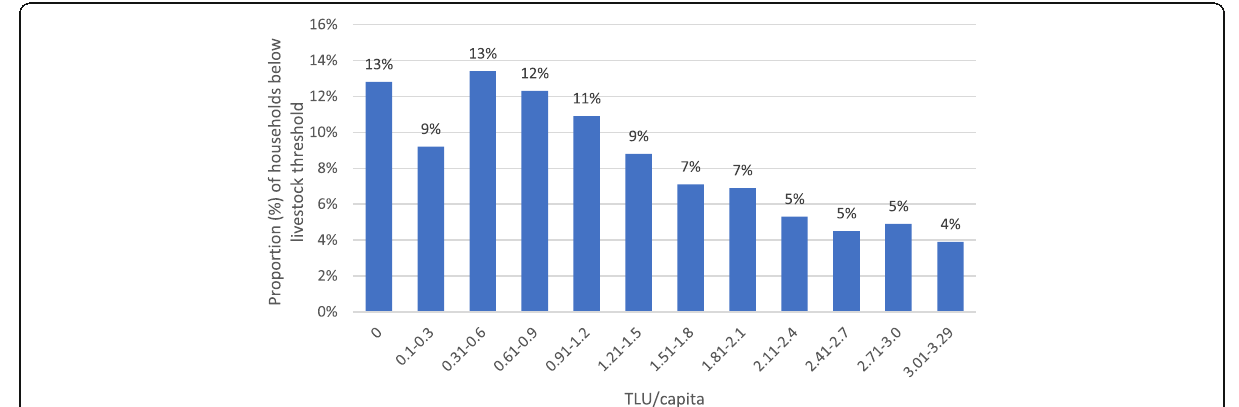
Fig. 3 Livestock ownership in households below the livestock threshold, Karamoja,